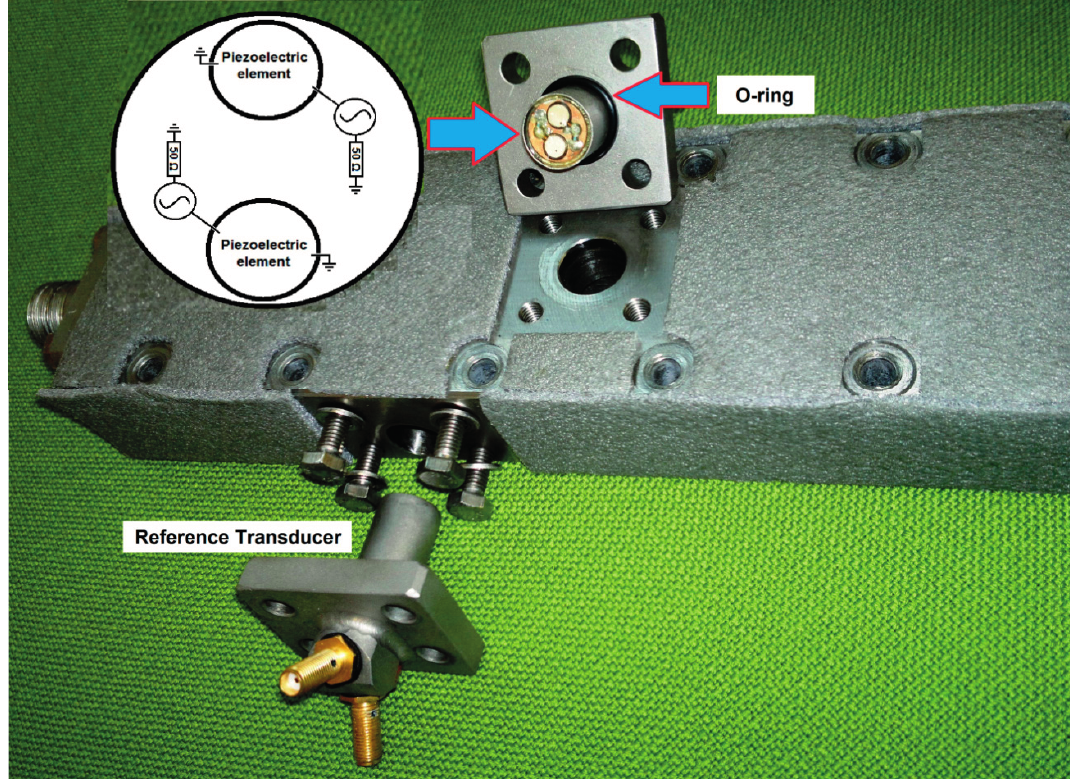
Figure 1. Two transducers with double piezoelectric elements are integrated inside the upper part of the membrane filtration module used in the study. Flow channel is inside the upper part of the module.